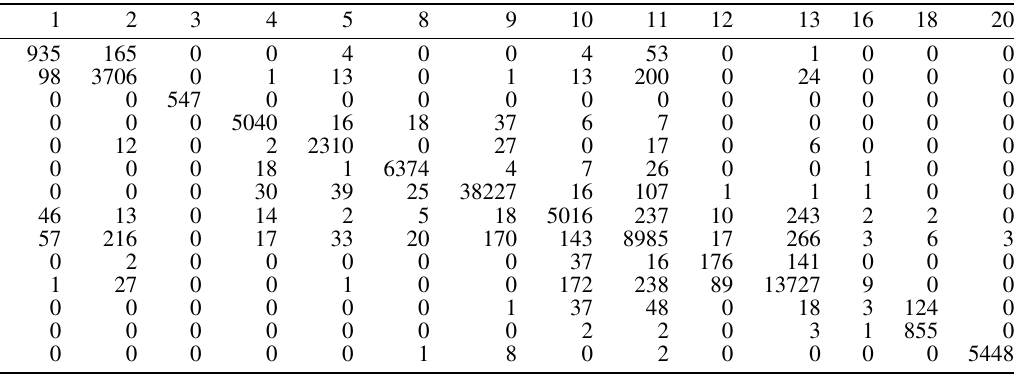
Table 2. Confusion matrix for the 14 class used on the DFC 2018 dataset.